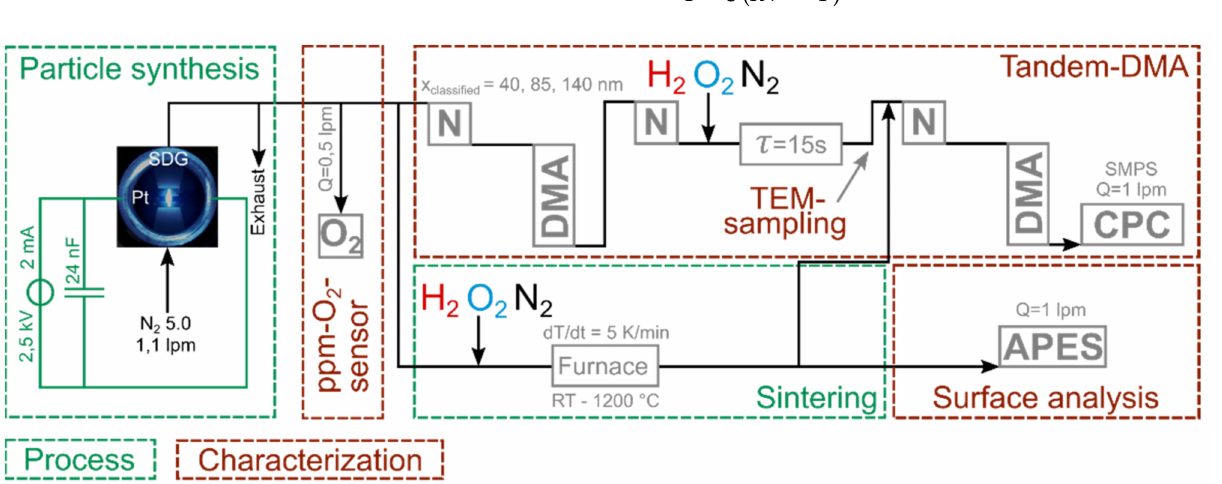
Figure 1. Experimental setup of particle synthesis, trace oxygen sensor, tandem DMA, sintering via tube furnace and APES. The admixture of reactive gases takes place seconds after the particle formation is completed, corresponding to the residence time of the aerosol between synthesis and point of gas addition. SDG: Spark discharge generator, O 2 : Trace oxygen sensor, DMA: Differential mobility analyzer, N: Soft X-ray neutralizer, CPC: Condensation particle counter, APES: Aerosol photoemission spectroscopy. The interconnection of N, DMA and CPC forms a Scanning Mobility Particle Sizer